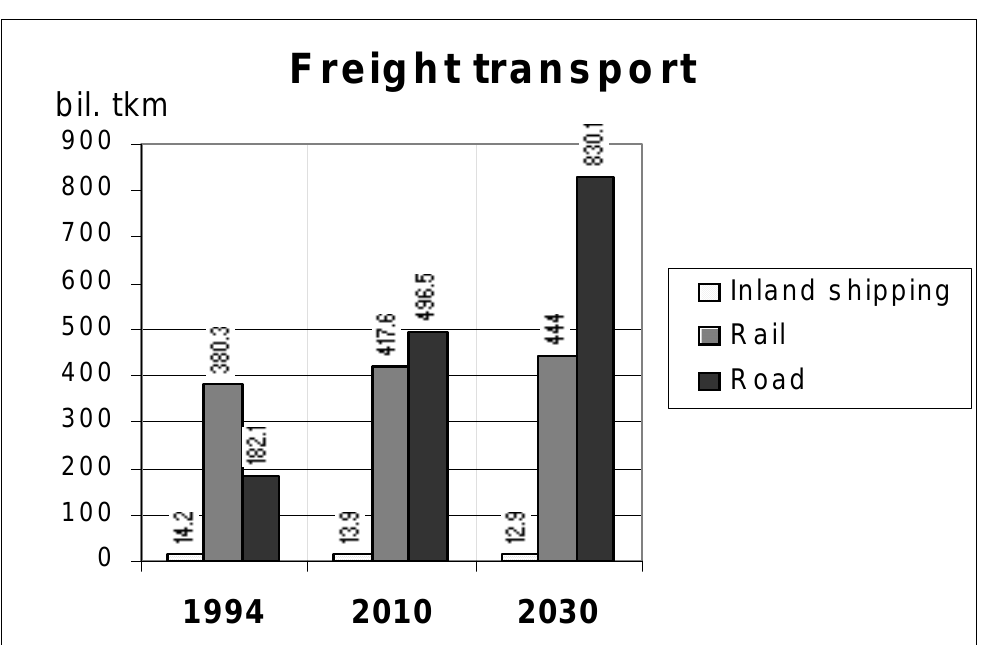
Figure 3. Current and projected modal split for freight transport in the CEI region As a result of these trends, modal share of private cars in passenger transport would rise from 46% to 69% from 1994 to 2030. The share of road freight (light- duty and heavy-duty trucks) in overall freight transport by might increase from 32% to 65%. The average distance travelled per capita and per year would increase from 5000 t about 10000 km; i.e., the current average level in EU countries. Also a large increase in air traffic is expected, especially for long-distance